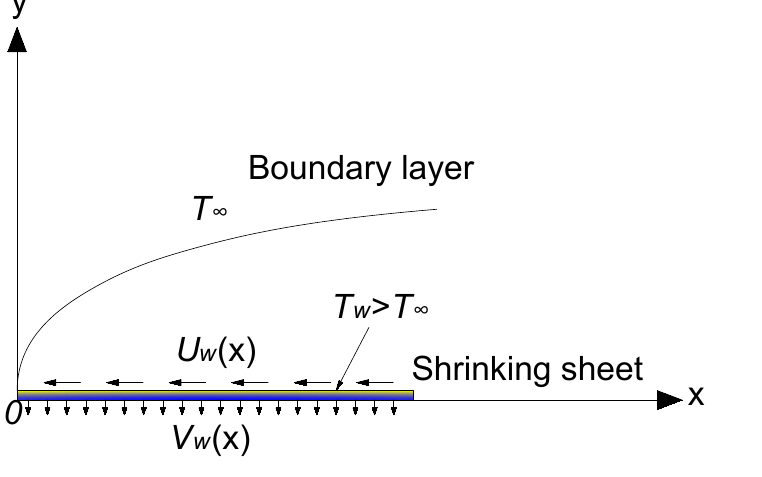
Figure 1. Physical model and coordinate